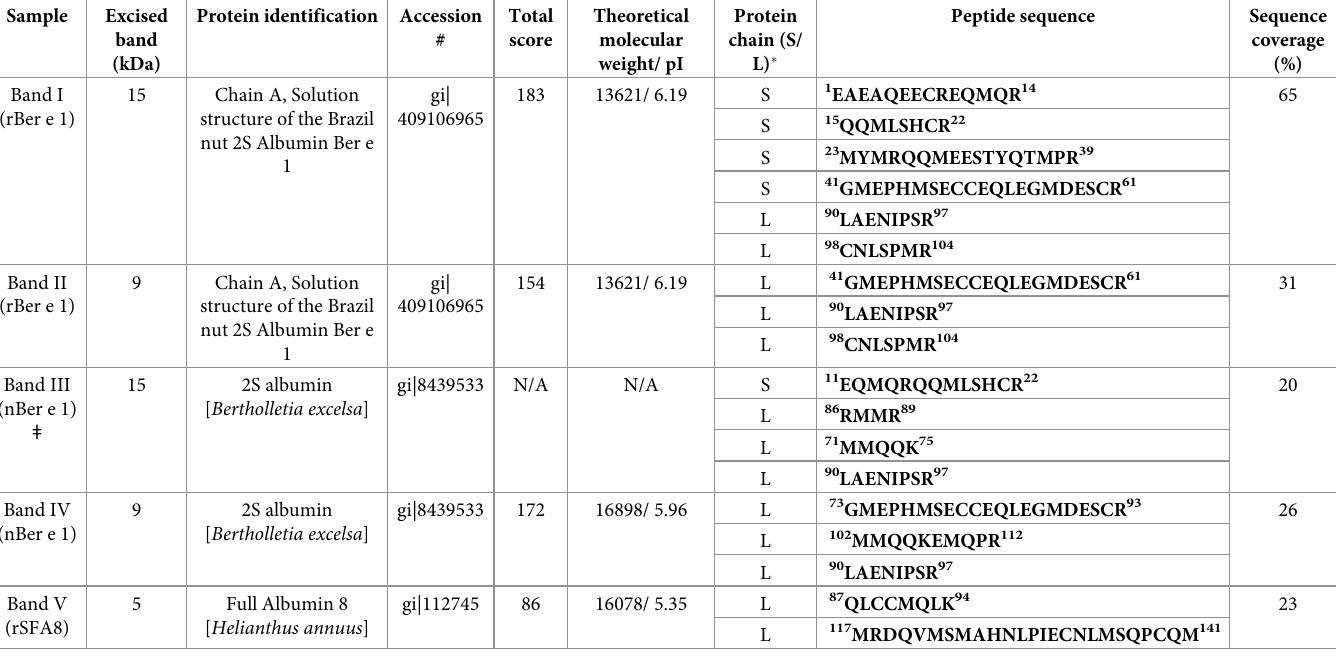
Table 2. Peptide sequence identified by ESI-Q-ToFII MS and MASCOT database search and de novo sequencing by Mass Lynx software.